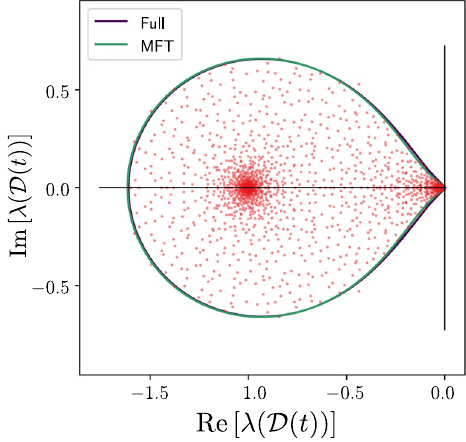
FIG. 8. Jacobian spectrum at a time-varying state. Red dots are the Jacobian eigenvalues for the full network in a (time-varying) steady state, and the spectral curve of the Jacobian is calculated using moments from (i) the full state vectors (blue curve) or using the variances from the fixed-point MFT (green). Surprisingly, the agreement is reasonably good. For network